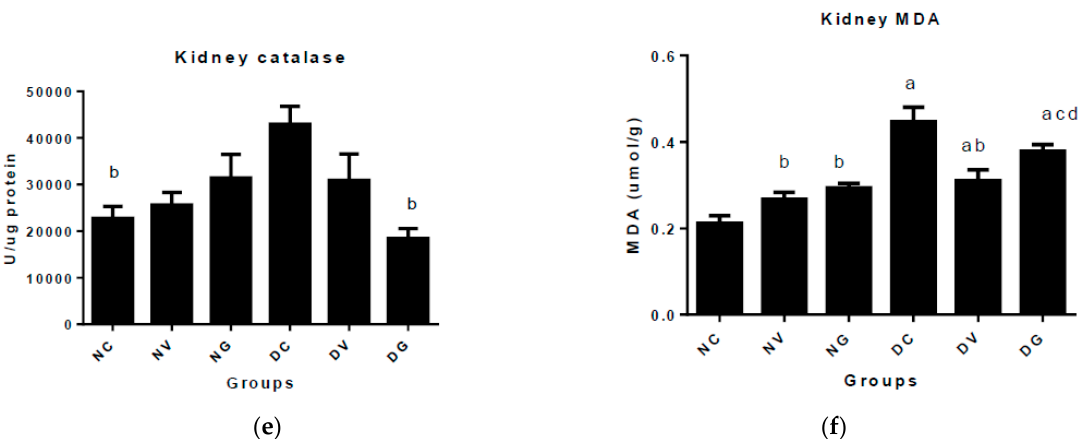
Figure 4. Markers of oxidative stress in the hearts and kidneys of normal and diabetic rats after treatment with vindoline and glibenclamide represented by the following subfigures: ( a ) represents the ferric reducing antioxidant power (FRAP) in the heart tissue; ( b ) catalase activity in the heart tissue; ( c ) SOD activity in the heart tissue; ( d ) oxygen radical absorbance capacity (ORAC) in the kidney tissue; ( e ) catalase activity in the kidney tissue; ( f ) lipid peroxidation (MDA) in the kidney tissue. Data represented as means ± SEM. a p < 0.05 vs. normal control. b p < 0.05 vs. diabetic control. c p < 0.05 vs. normal rats treated with vindoline. d p < 0.05 vs. normal rats treated with glibenclamide. NC: normal control; NV: normal control treated with vindoline; NG: normal control treated with glibenclamide; DC: diabetic control; DV: diabetic treated with vindoline; DG: diabetic treated with glibenclamide.